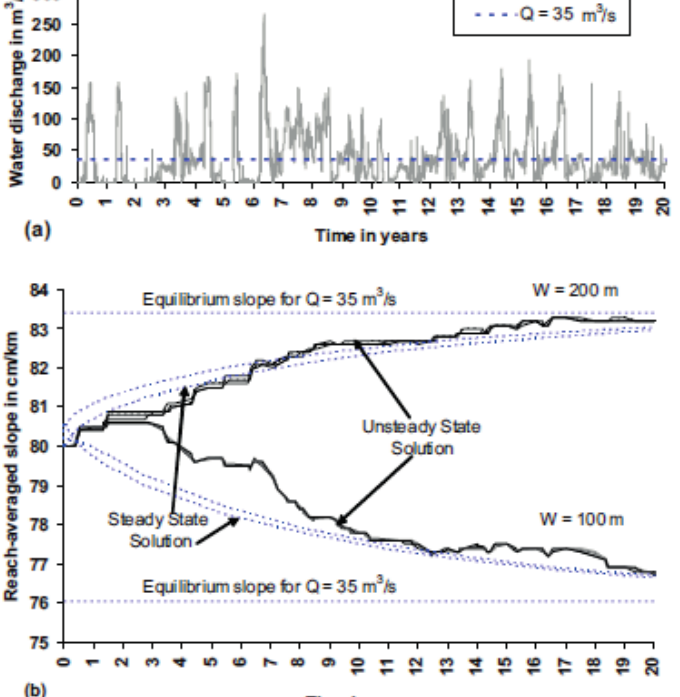
Fig. 7 Channel slope changes as a result of channel width changes on the Rio Grande from Leon et al .